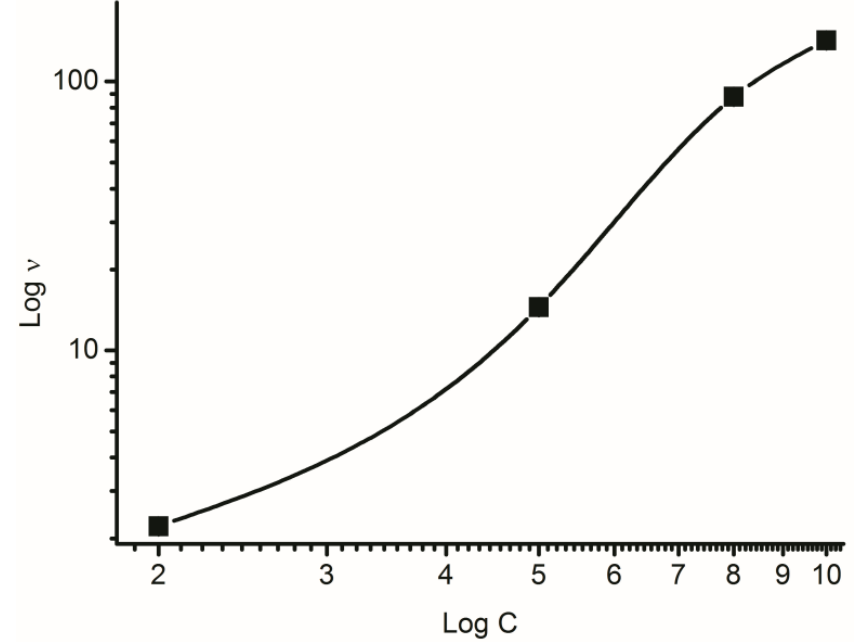
Figure 3. Variation of kinematic viscosity with polymer solution concentration (where ν is kinematic viscosity and C is polymer solution